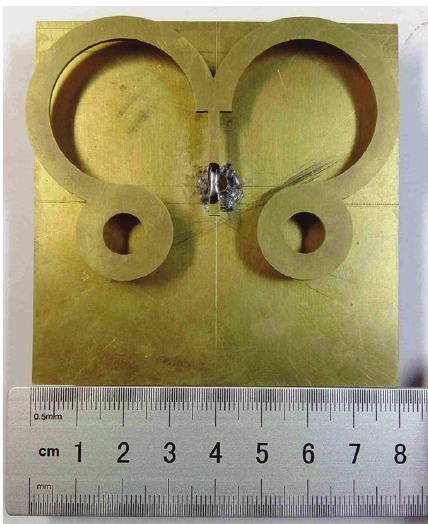
Figure 10: Photograph of the proposed antenna.